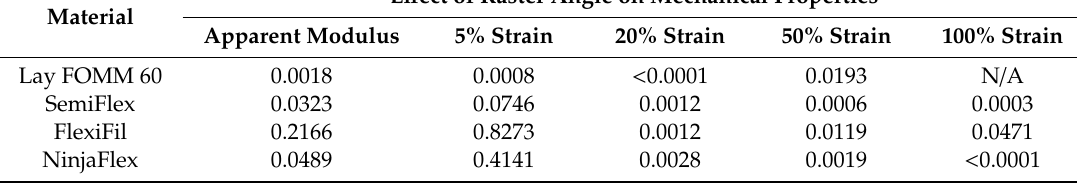
Table 4. Results of one-way ANOVA comparing e ff ects of raster angle on mechanical properties of flexible materials.